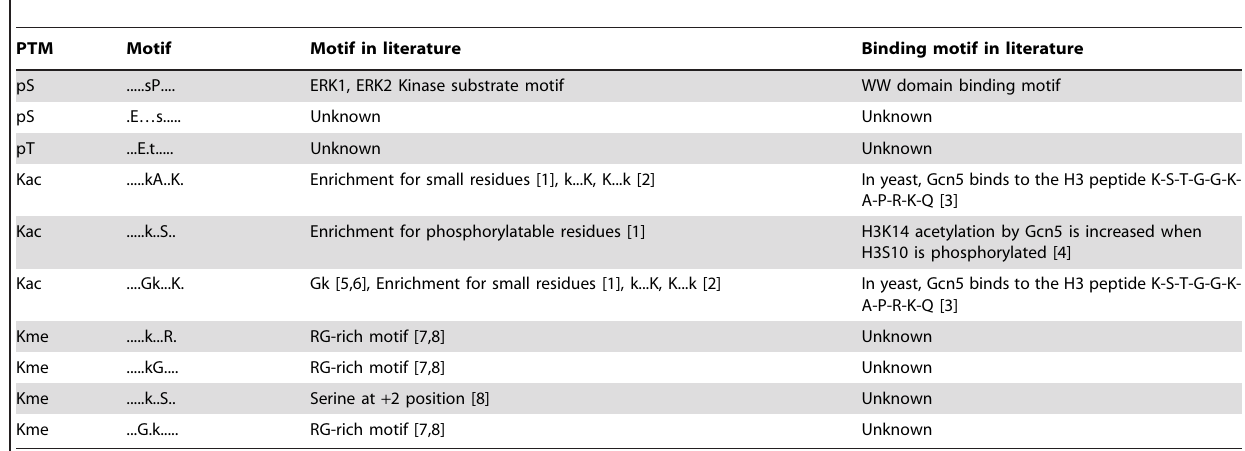
Table 2. Summary of overrepresented motifs at PTM